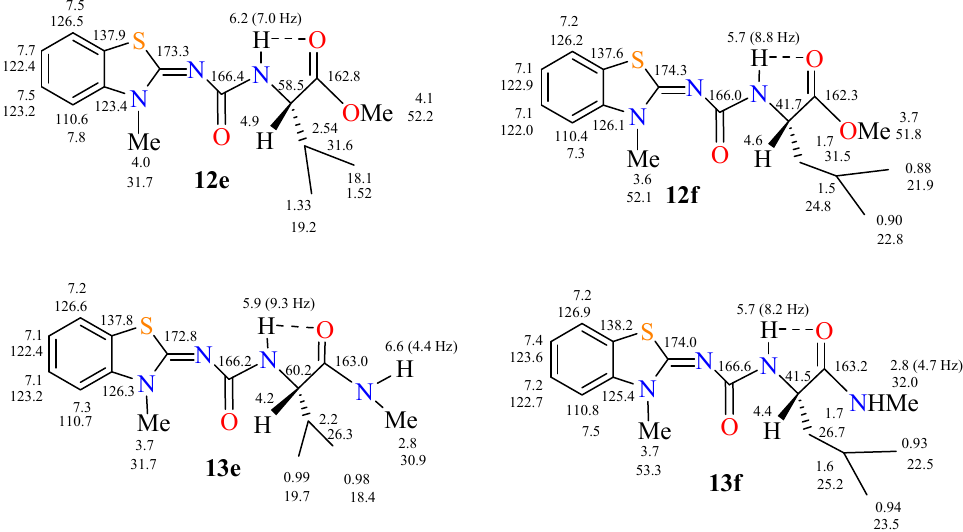
Figure 2. 1 H and 13 C NMR data in CDCl 3 of urea carboxylate methyl esters 12e , 12f , and their corresponding urea NMe amides 13e , 13f .